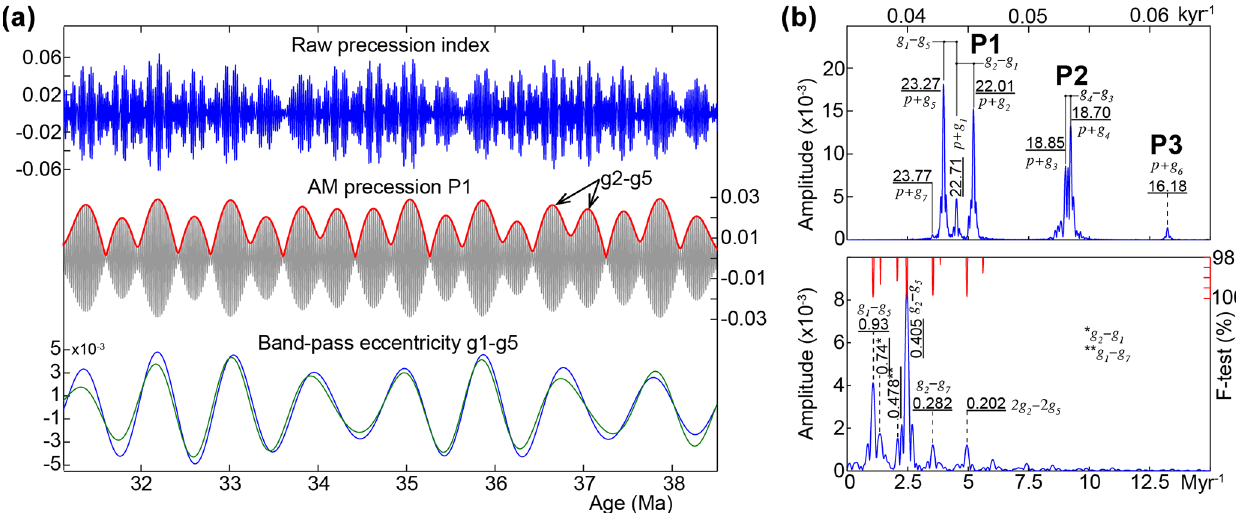
Figure 6. Amplitude modulation (AM) of the precession index band P1. (a) La2004 precession index (Laskar et al., 2004), AM of precession P1 band (cut-off frequencies: 0.044 ± 0.002 cycles every thousand years), and band-pass filtering of the g1–g5 eccentricity component (cut- off frequencies: 0.00115 ± 0.0003 cycles every thousand years) from AM precession P1 (blue curve) and from the raw eccentricity (green curve). (b) 2 π -MTM amplitude spectra of the raw precession index (upper panel) and AM precession P1 (lower